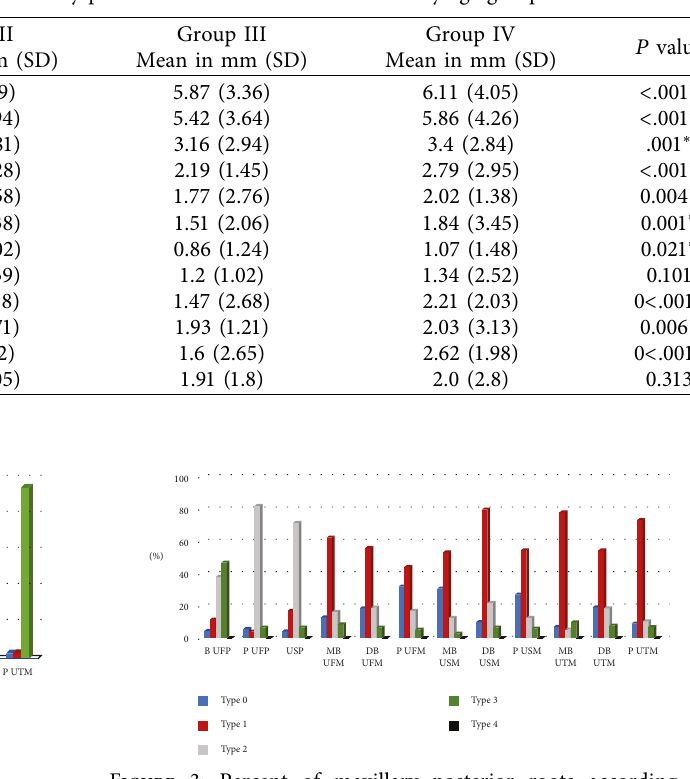
Figure 2: Distribution of different roots in relation to distance from maxillary sinus floor.